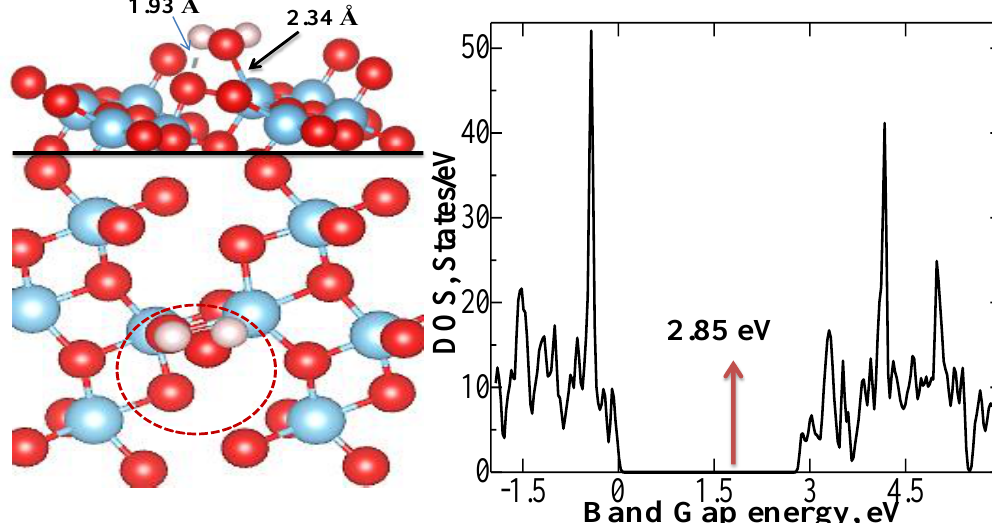
Figure 3. Structural images of the top layer and DOS of the TiO 2 system during adsorption of H 2 O - molecules parallel to the X